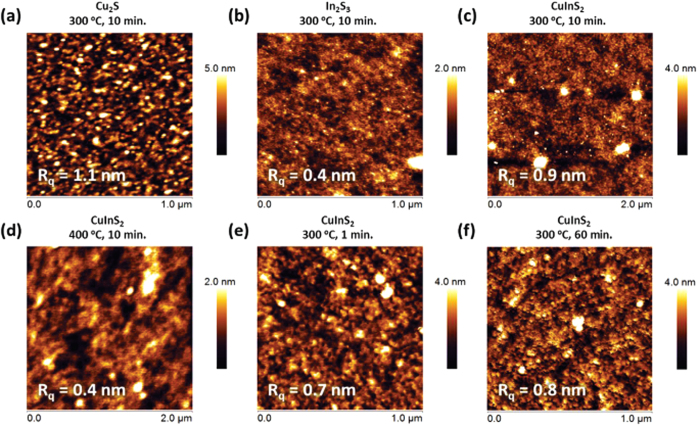
AFM images showing (a) Cu2S, (b) In2S3 and (c) CuInS2 films prepared by annealing the corresponding metal thiolates at 300 °C for 10 minutes. Image (d) shows a CuInS2 film annealed at a higher temperature of 400 °C while images (e) and (f) show films annealed at 300 °C for 1 and 60 minutes, respectively.